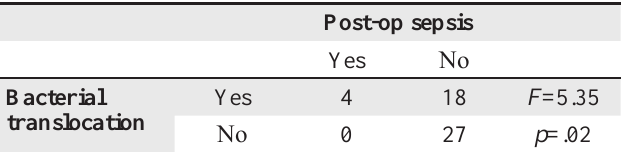
Table 2 : Relation between Bacterial translocation and Post- operative